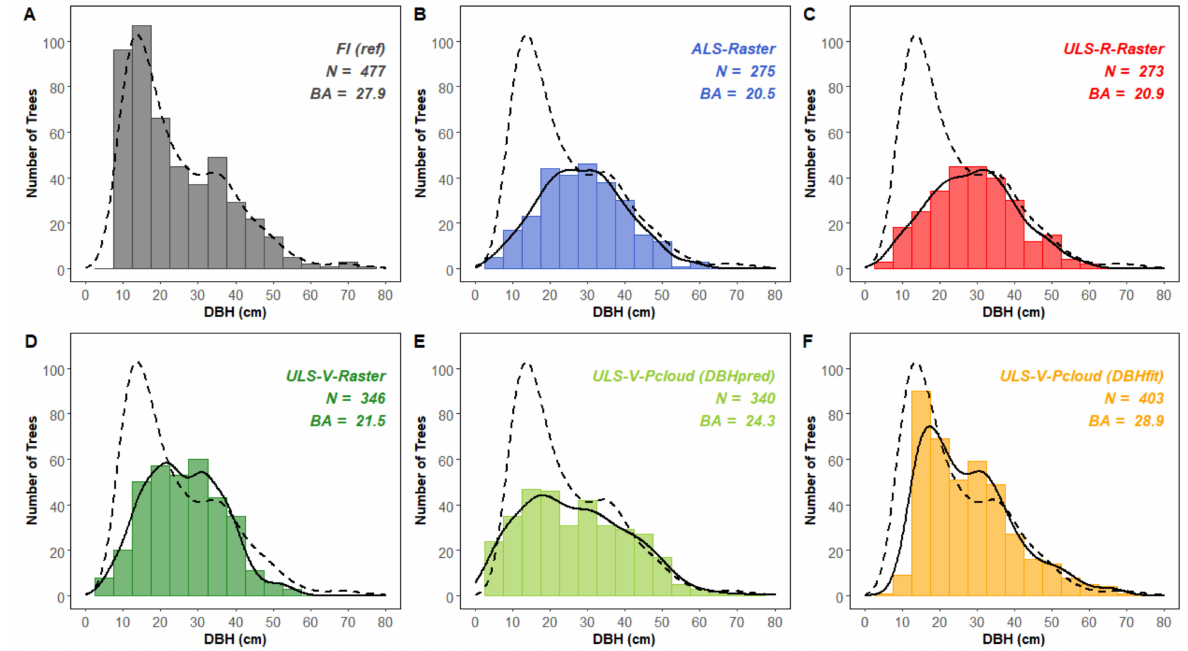
Figure 15. DBH-distribution of the stand (by 5 cm-class increments) ( A ) as measured from field-inventory (FI)—used as reference—and compared with estimates from ( B ) ALS-Raster (leaf-on), ( C ) ULS-R-Raster (leaf-on), ( D ) ULS-V-Raster (leaf-off), ( E ) ULS-V-Pcloud (DBH pred ) (leaf-off) and ( F ) ULS-V-Pcloud (DBH fit ) (leaf-off). The dashed line represents fitting curve from the FI reference histogram. Lines represent fitted curves that were produced from a spline. N is the estimated tree count ( Ntrees det ) and BA is the estimated basal area (m 2